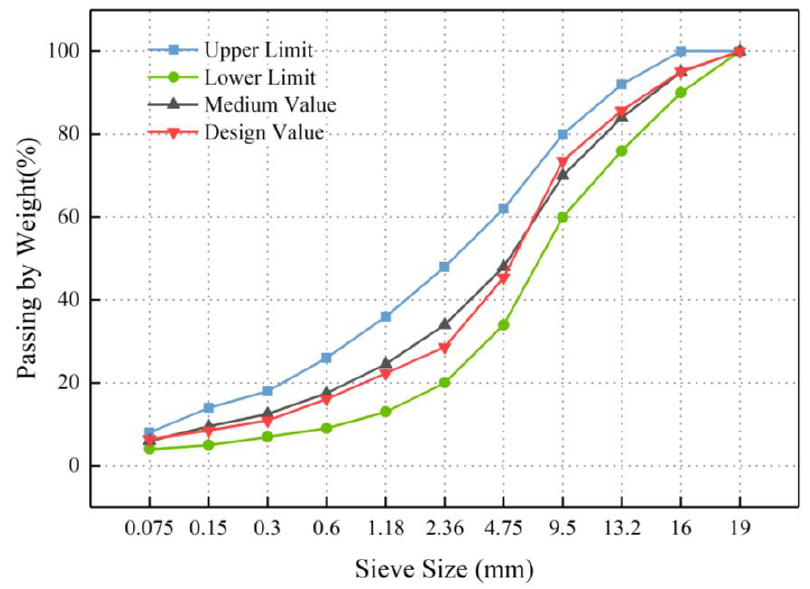
Figure 3. Gradation curve of AC-16.